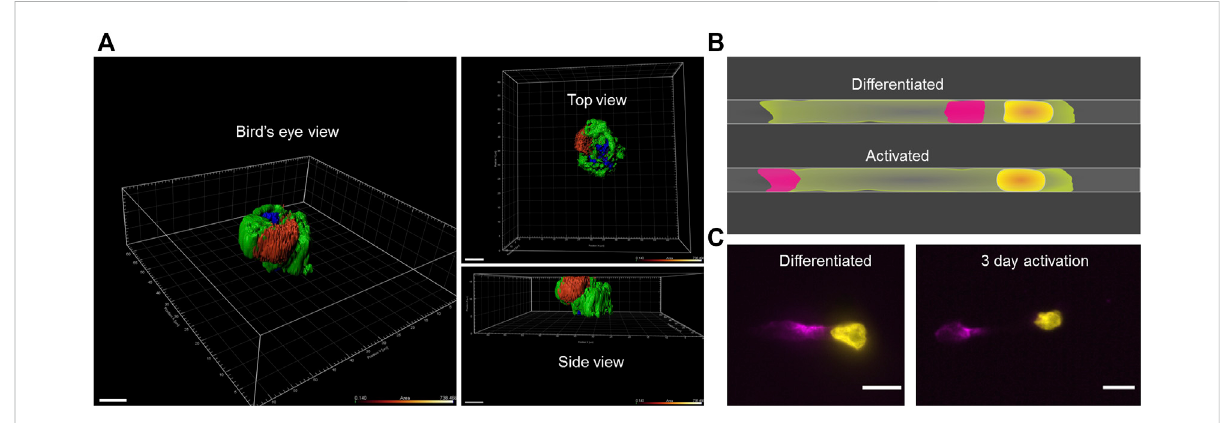
FIGURE 3 Visualisation of surface vimentin on macrophages patterned on one-dimensional lines. (A) Representative three-dimensional projections of a TNF- α – activated macrophage (red, surface vimentin: green, cell membrane), demonstrated using IMARIS. Scale bar, 7 µm. (B) Illustration of the vimentinsecretionsites(red)forthedifferentiatedandTNF- α – activatedmacrophagesusingpatternedlines.Yellow,nucleus;green,cellmembrane. (C) RepresentativedifferentiatedandTNF- α – activatedmacrophageattachedandelongatedalongthepatternonaglasscoverslip,revealingthe site of vimentin secretion (yellow, nucleus; magenta, extracellular cell-surface vimentin). Scale bar, 10 μ